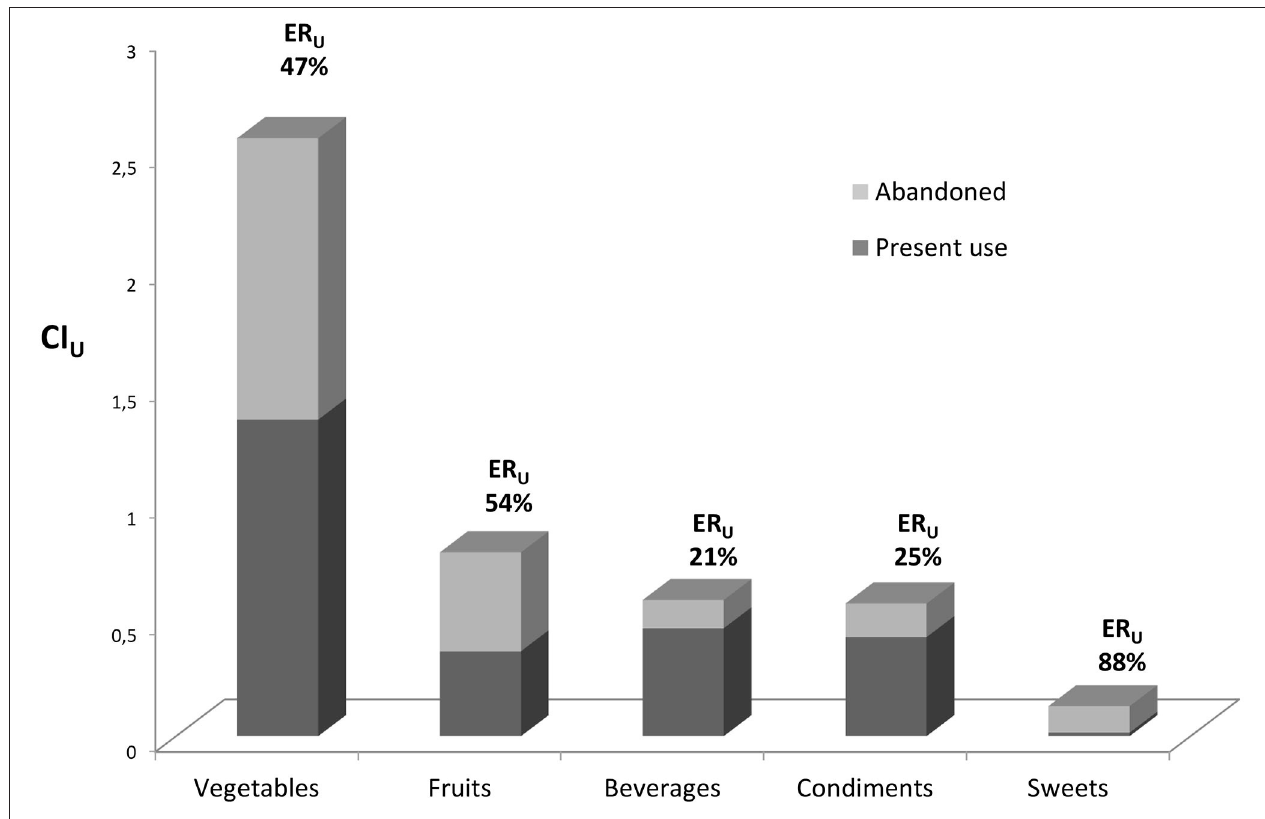
FIGURE 5 | Cultural importance index (CI) of the food